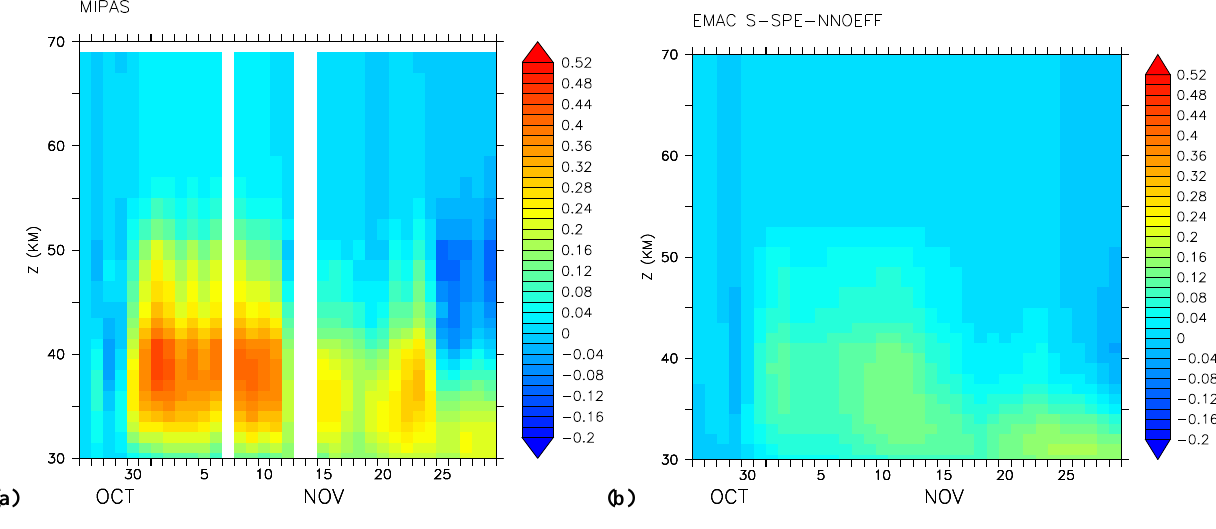
Fig. 16. ClONO 2 changes (ppbv) for 70–90 ◦ N relative to 26 October 2003; (a) MIPAS, (b) EMAC simulation